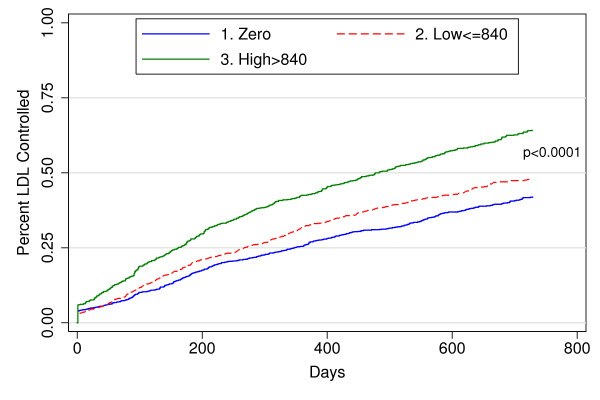
Time Until LDL Cholesterol Control for Four Race-Gender Groups.